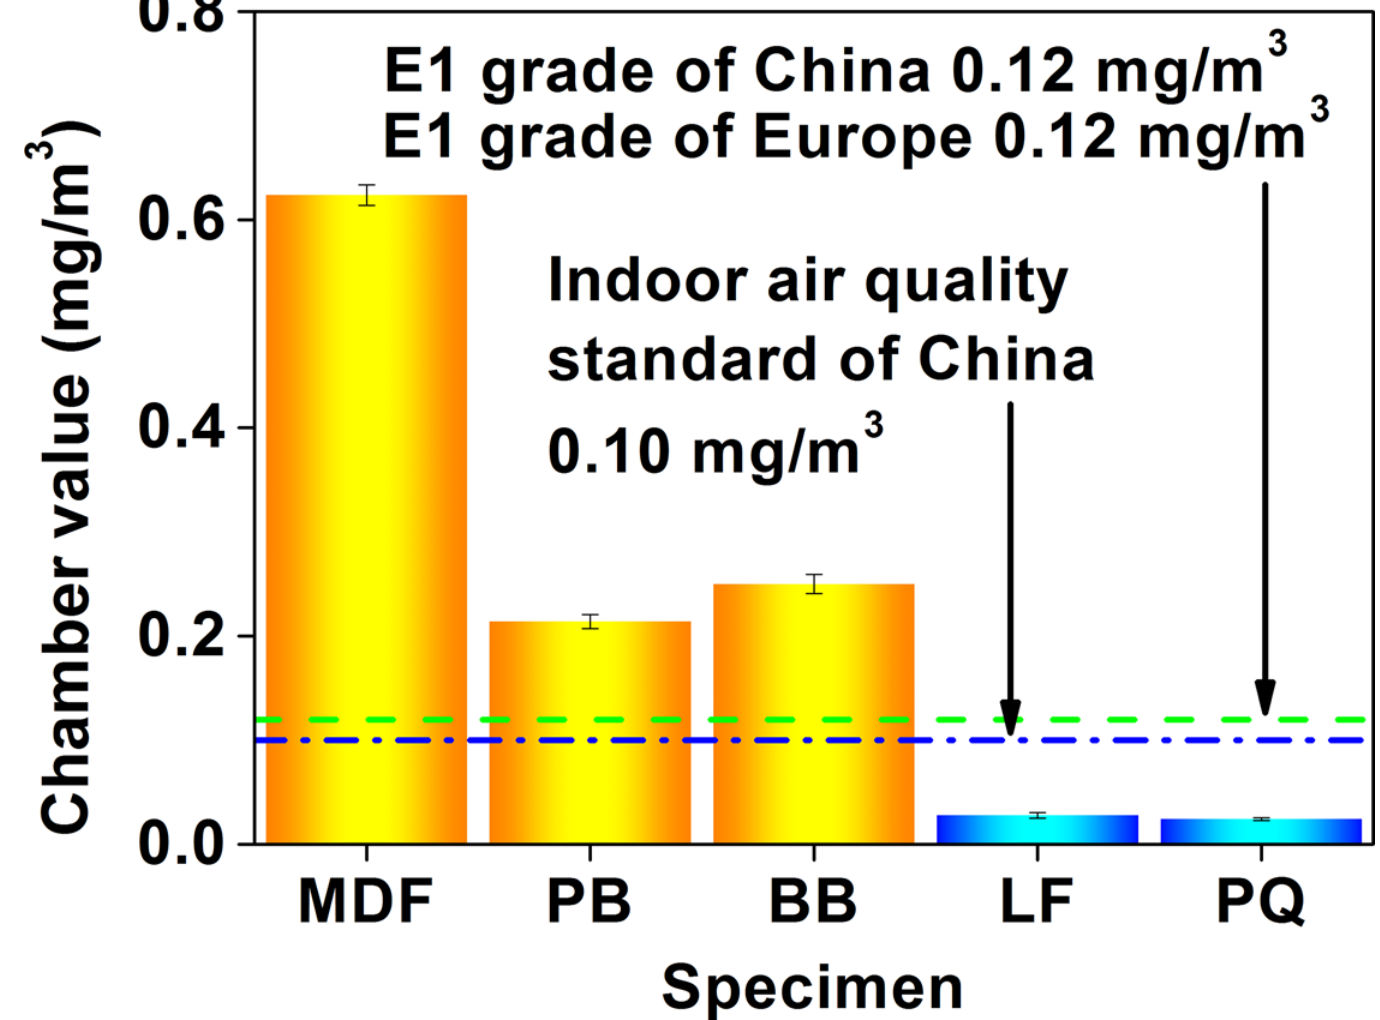
Fig 6. Formaldehyde emission values (chamber value) of various materials characterized by the environmental chamber method of the Chinese national standard GB 18580. MDF, medium density fiberboard; PB, particleboard; BB, blockboard; LF, laminate flooring; PQ,